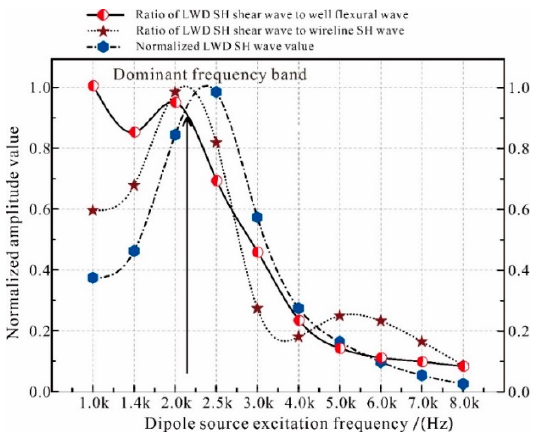
Figure 4. Far-field radiation patterns of the LWD SH ( a ) and SV ( b ) waves for different source frequencies.